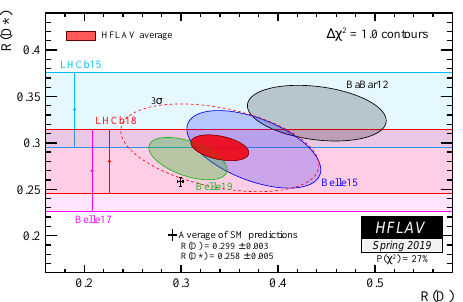
Figure 4: HFLAV average of all measurements of R ( D ) and R ( D ∗ ), updated with the latest result of the Belle collaboration presented in these proceedings. The red ellipse shows the combined average and the data point is the SM prediction, showing a discrepancy of 3.1 σ . This plot is retrieved from the HFLAV website